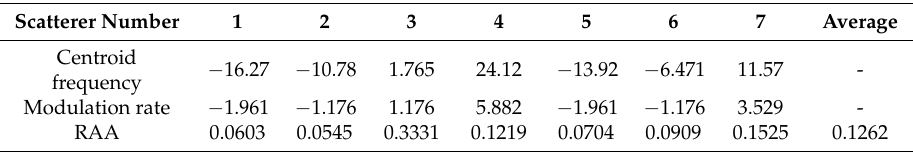
Figure 5. Parameter estimation of LFM signal. ( a ) Signal in range cell 506; ( b ) signal in range cell 465. Table 2. Rough RAA values based on parameter estimation of LFM signals.